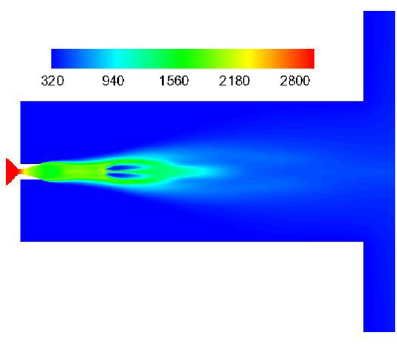
Figure 15. Temperature contour of the XOZ plane in case D.